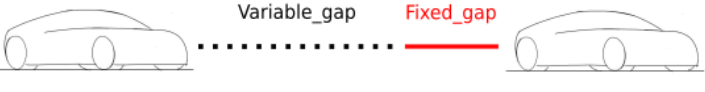
Figure 6. Safety distance with the header car.